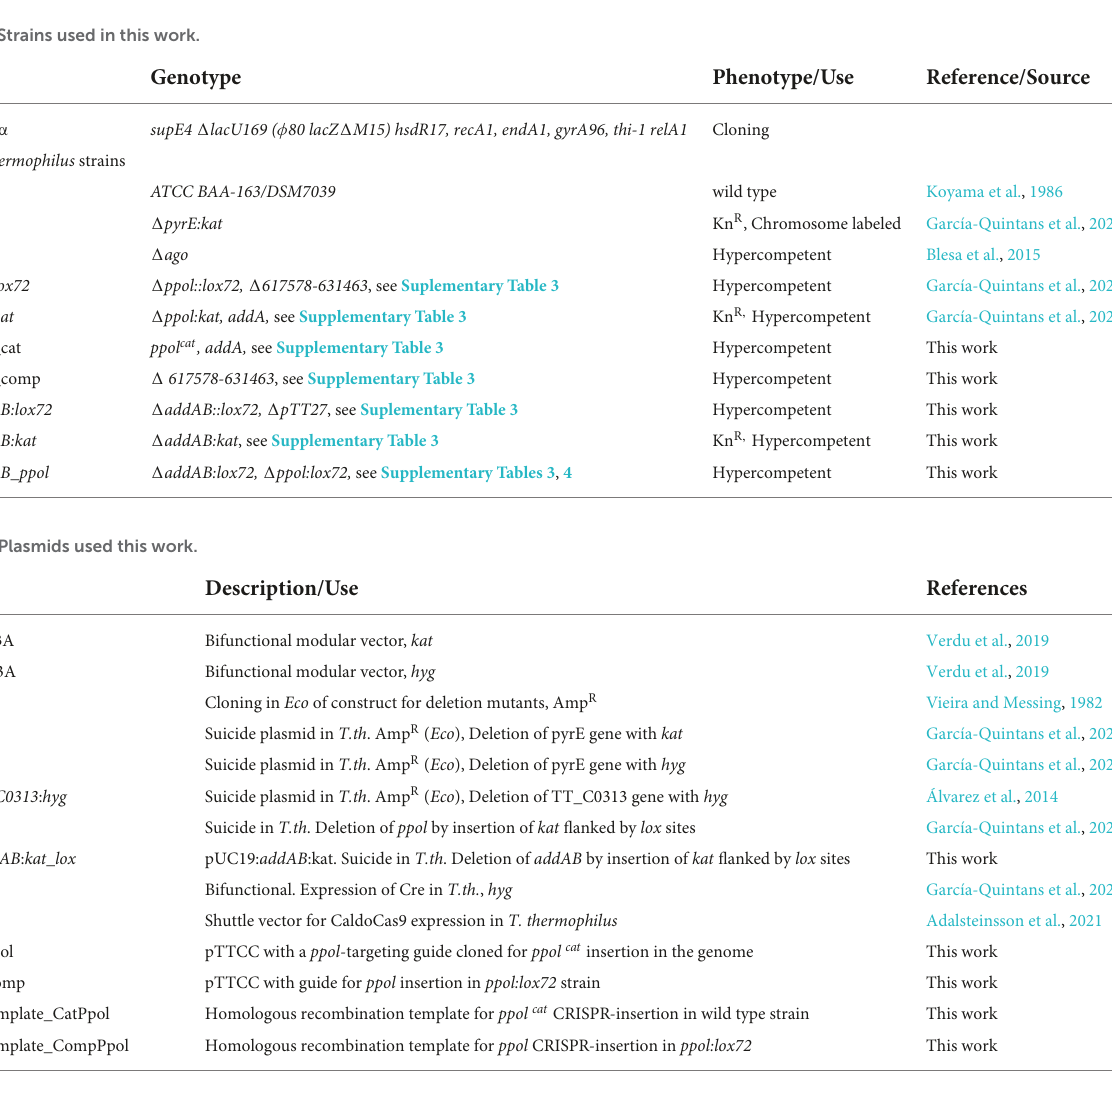
TABLE 3 Strains used in this work.